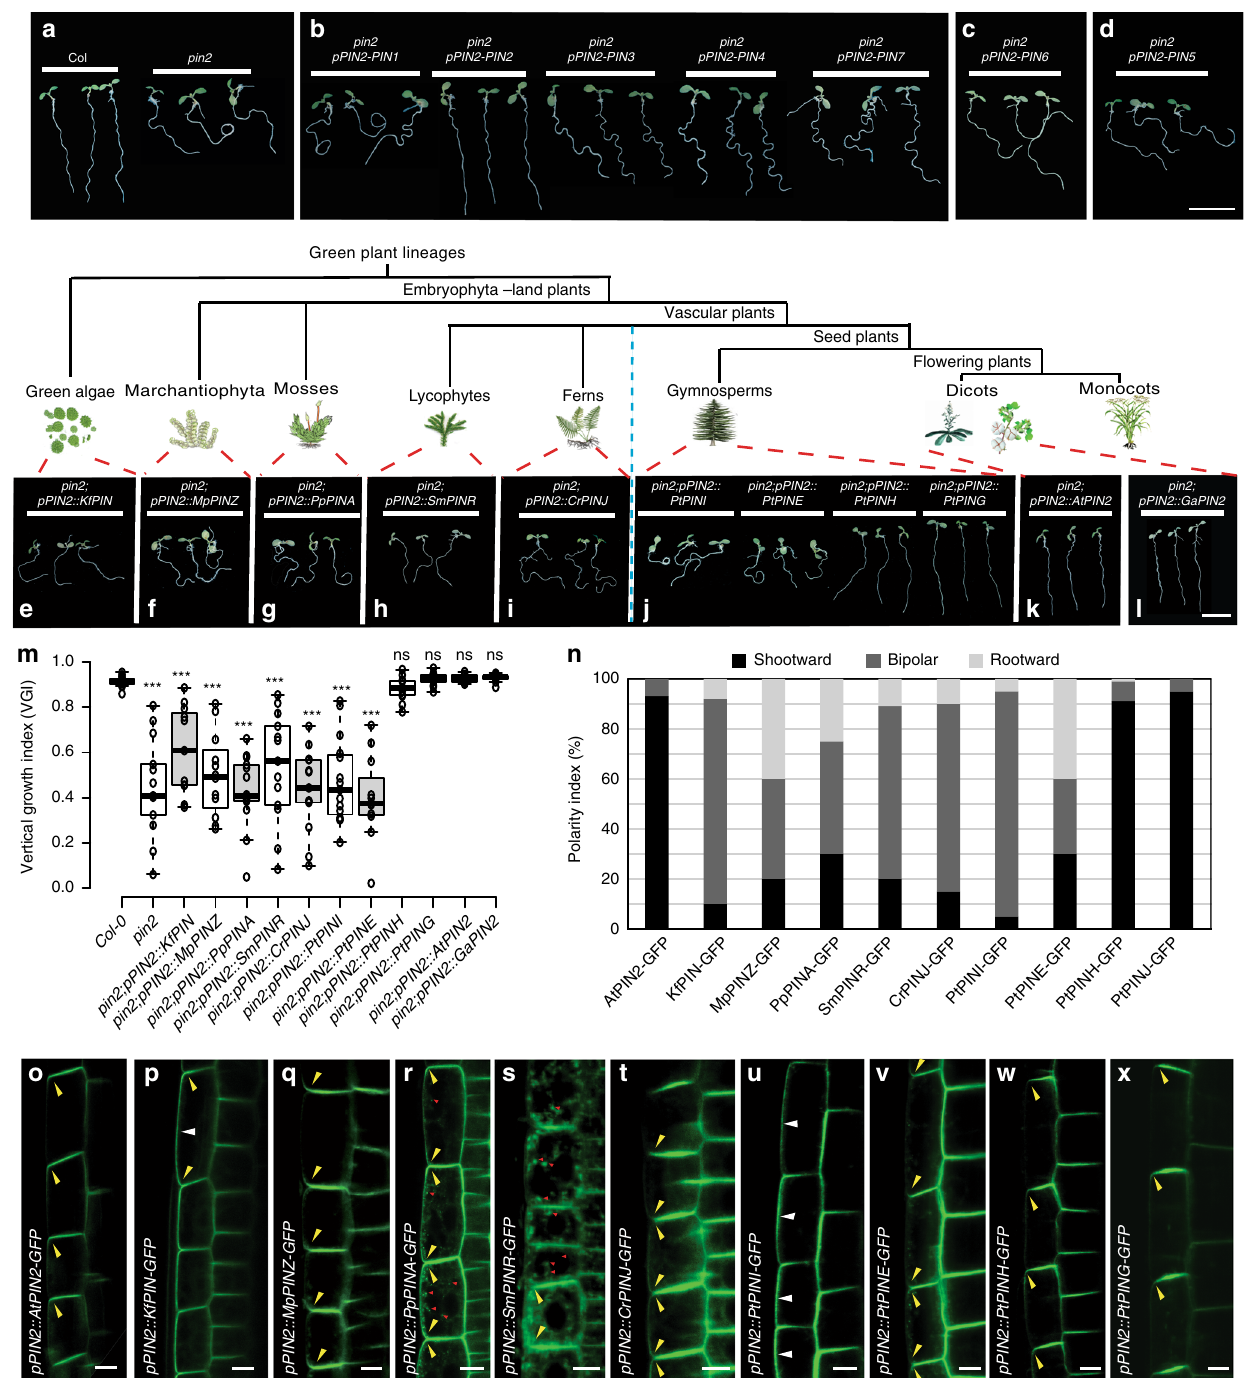
these cells (Fig. 3n, p). The marchantia MpPINZ-GFP, the moss PpPINA-GFP and PpPINB-GFP, and the lycophyte SmPINR-